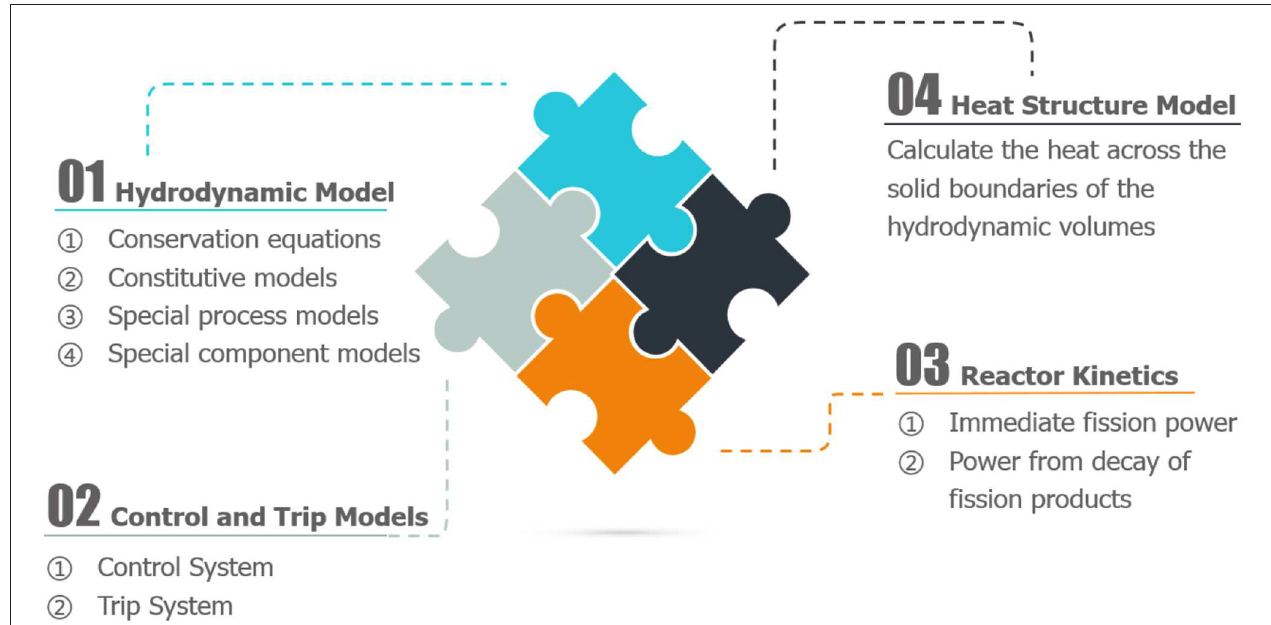
FIGURE 3 | Modular structure of LOCUST.